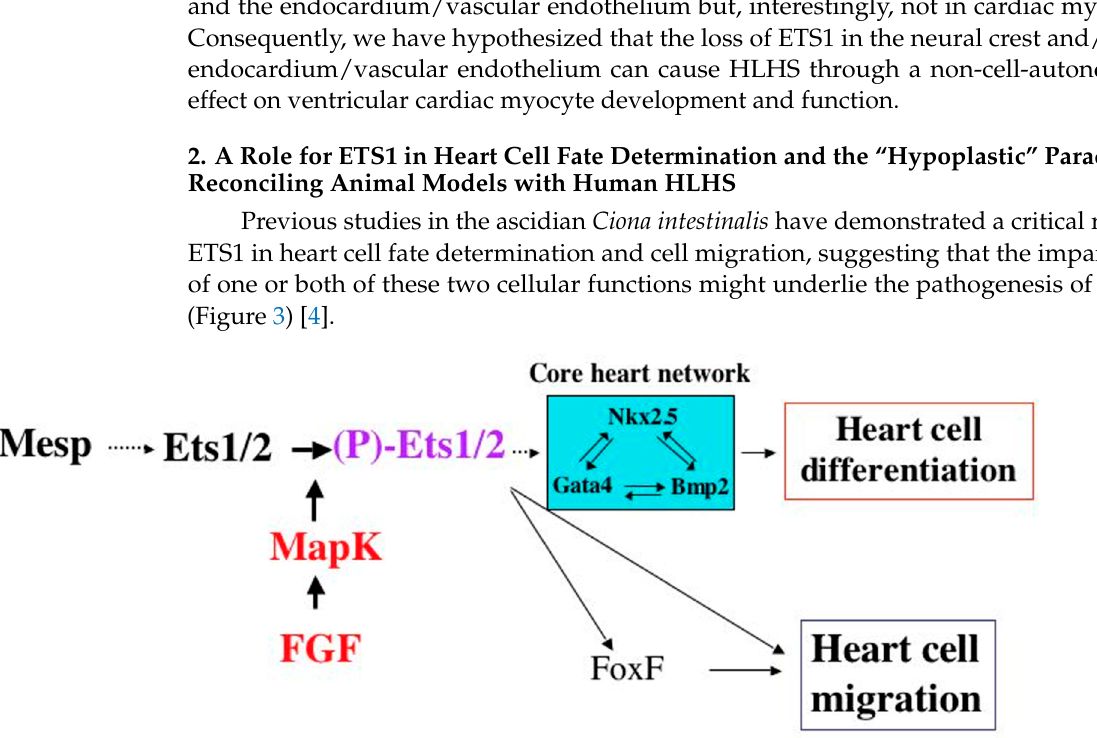
Figure 3. Ciona heart specification network. Schematic diagram depicting the transcriptional core network of genes involved in heart development in Ciona intestinalis . Mutations in at least three of these genes (ETS1, NKX2-5, and FoxF1) have been identified in patients in association with HLHS. (Kindly provided by Dr. Brad Davidson.)